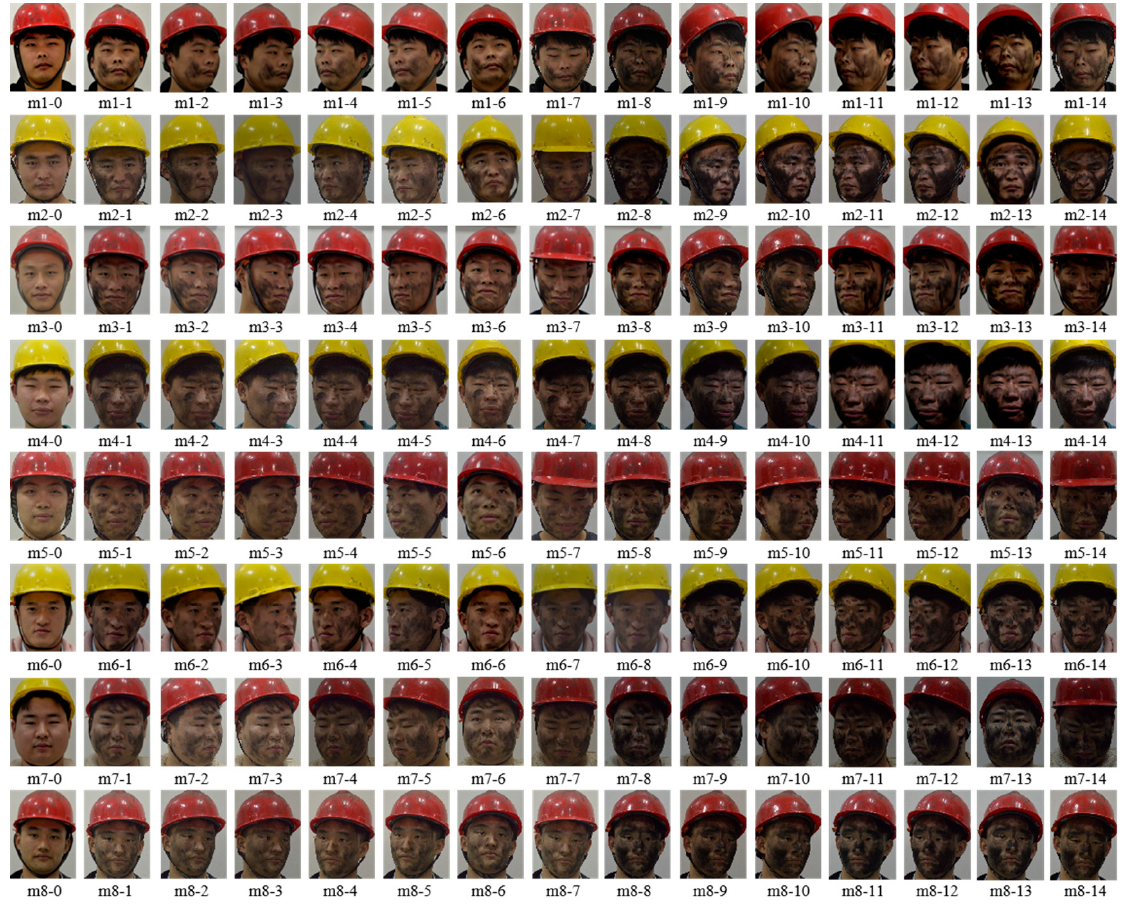
Figure 15. Part of facial images with coal ash.